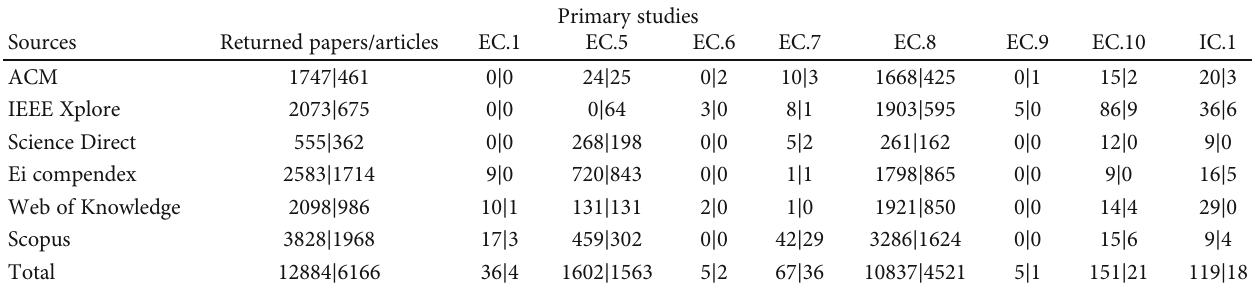
Table 5: Studies returned and remaining studies through the stages of SRL (the table follows the S|M standard, in which S stands for software process improvement papers/articles and M for software measurement papers/articles).